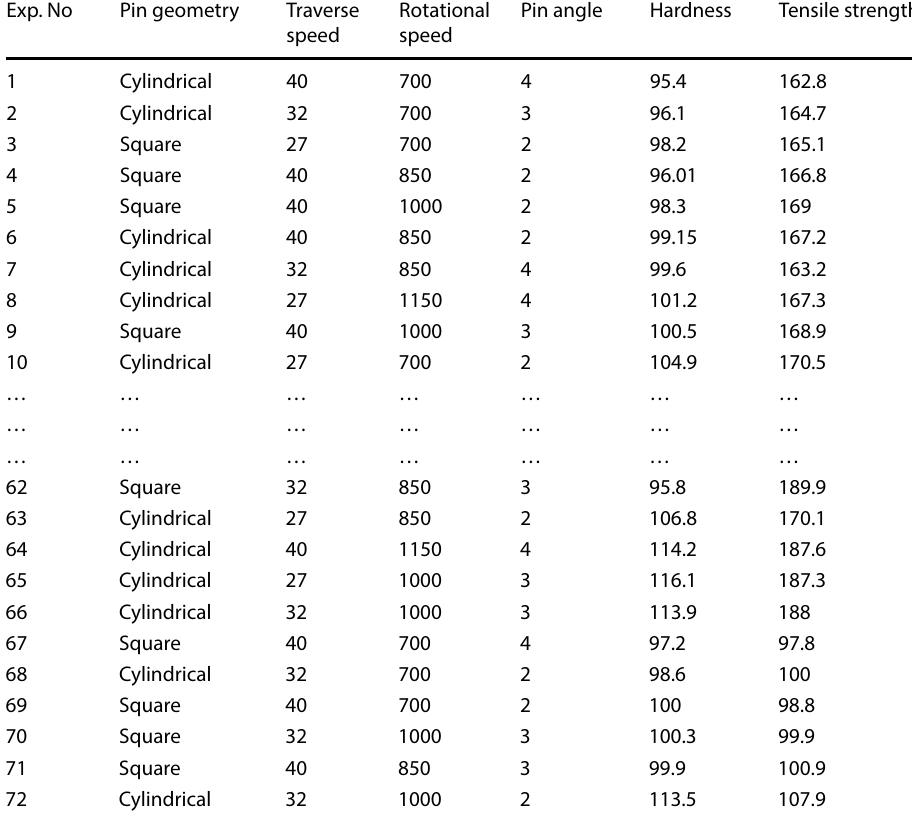
Table 3 Experimental test using Full Factorial